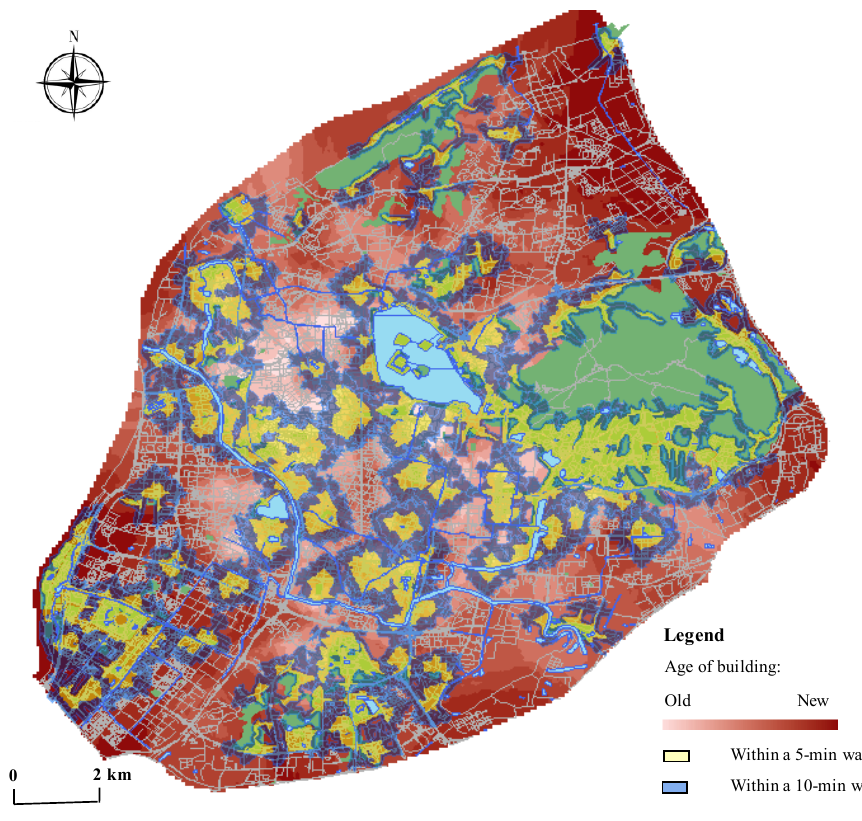
Figure 5. The distribution of park accessibility and the year-built of housings in Nanjing.